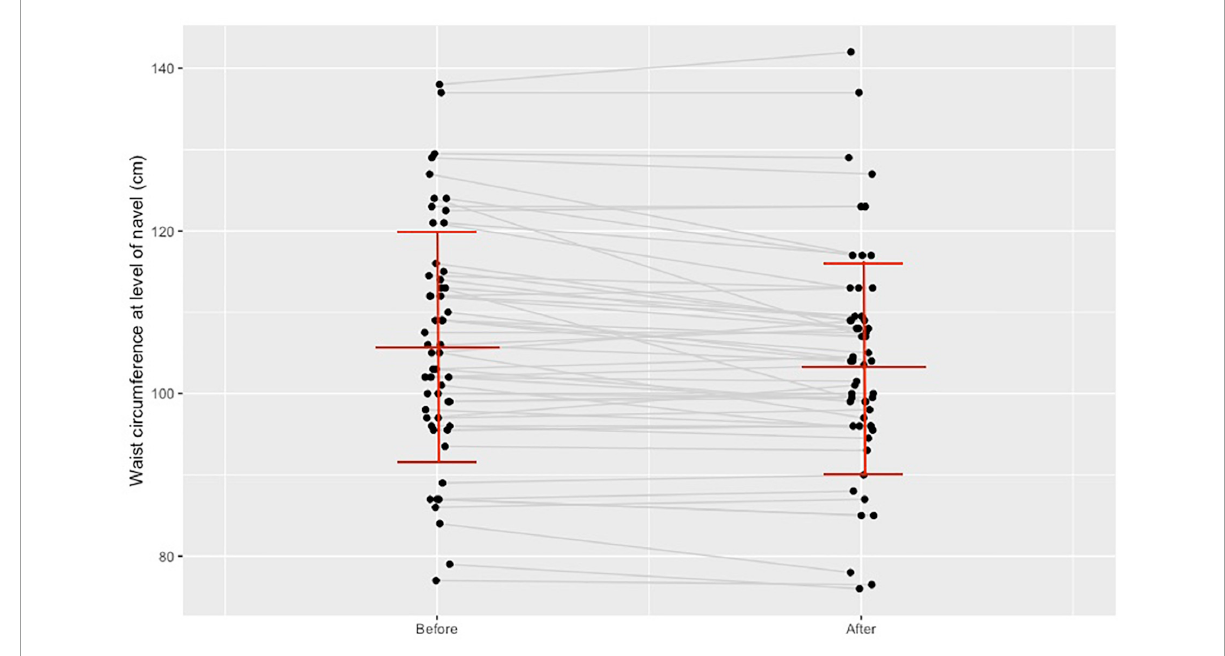
FIGURE1 Change in the waist circumference measured at navel level before and after the training program.